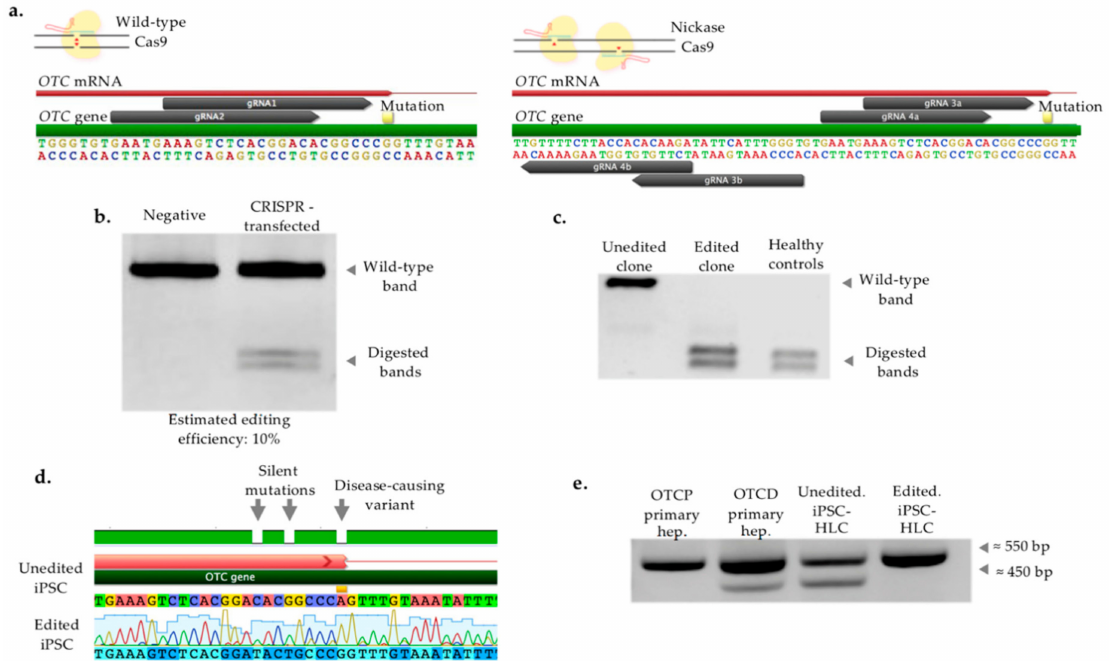
Figure 3. CRISPR/Cas9-mediated gene targeting of patient’s OTCD iPSC. ( a ) Genome engineering strategies. Single guide RNA (gRNA1, gRNA2) ( left panel ) and dual gRNA (combination of gRNA3a with gRNA3b, and gRNA4a with gRNA4b) ( right panel ) approaches were used to achieve the best editing efficiency. Single guides were delivered along with wild-type Cas9, while dual guides with nickase Cas9. Position of mutation respective to gRNAs is marked in the figure. ( b ) Assessment of cleavage efficiency. Editing efficiency was estimated based on intensities of wild-type and cleaved bands following restriction enzyme digestion. Negative: untransfected cells. CRISPR-transfected: cells transfected with Cas9 and gRNA. ( c ) Restriction enzyme assay—clone screening. A total number of 54 iPSC clones were serially isolated, expanded and screened. Screening was conducted with restriction enzyme digestion assay which would digest only successfully corrected DNA sequence of targeted region. One iPSC clone was edited on both alleles having only digested bands, similar to the healthy control (positive control). A representative unedited clone is also shown. ( d ) Sequencing of genomic DNA of unedited and edited clones. The genomic region of interest containing the disease-causing variant was Sanger-sequenced in unedited and edited iPSC clones. Three base pairs were identified as differences between the parental and the engineered cells (indicated with arrows), as expected. Two of those are silent mutations which were deliberately introduced to increase the correction efficiency, and one is the mutation intended to be edited to correct OTC deficiency. ( e ) Investigation of OTC transcript. Amplification of OTC transcript spanning from exon 1 to exon 5 was performed in OTC-proficient (OTCP) primary and OTCD primary hepatocytes, as well as in unedited and edited iPSC hepatocyte-like cells (iPSC-HLC). One wild-type band was presented in cells correctly expressing the gene (OTCP primary hepatocytes and edited iPSC-HLC), while two bands (wild-type and shorter band due to exon skipping) in genetically defected cells (OTCD primary hepatocytes and unedited